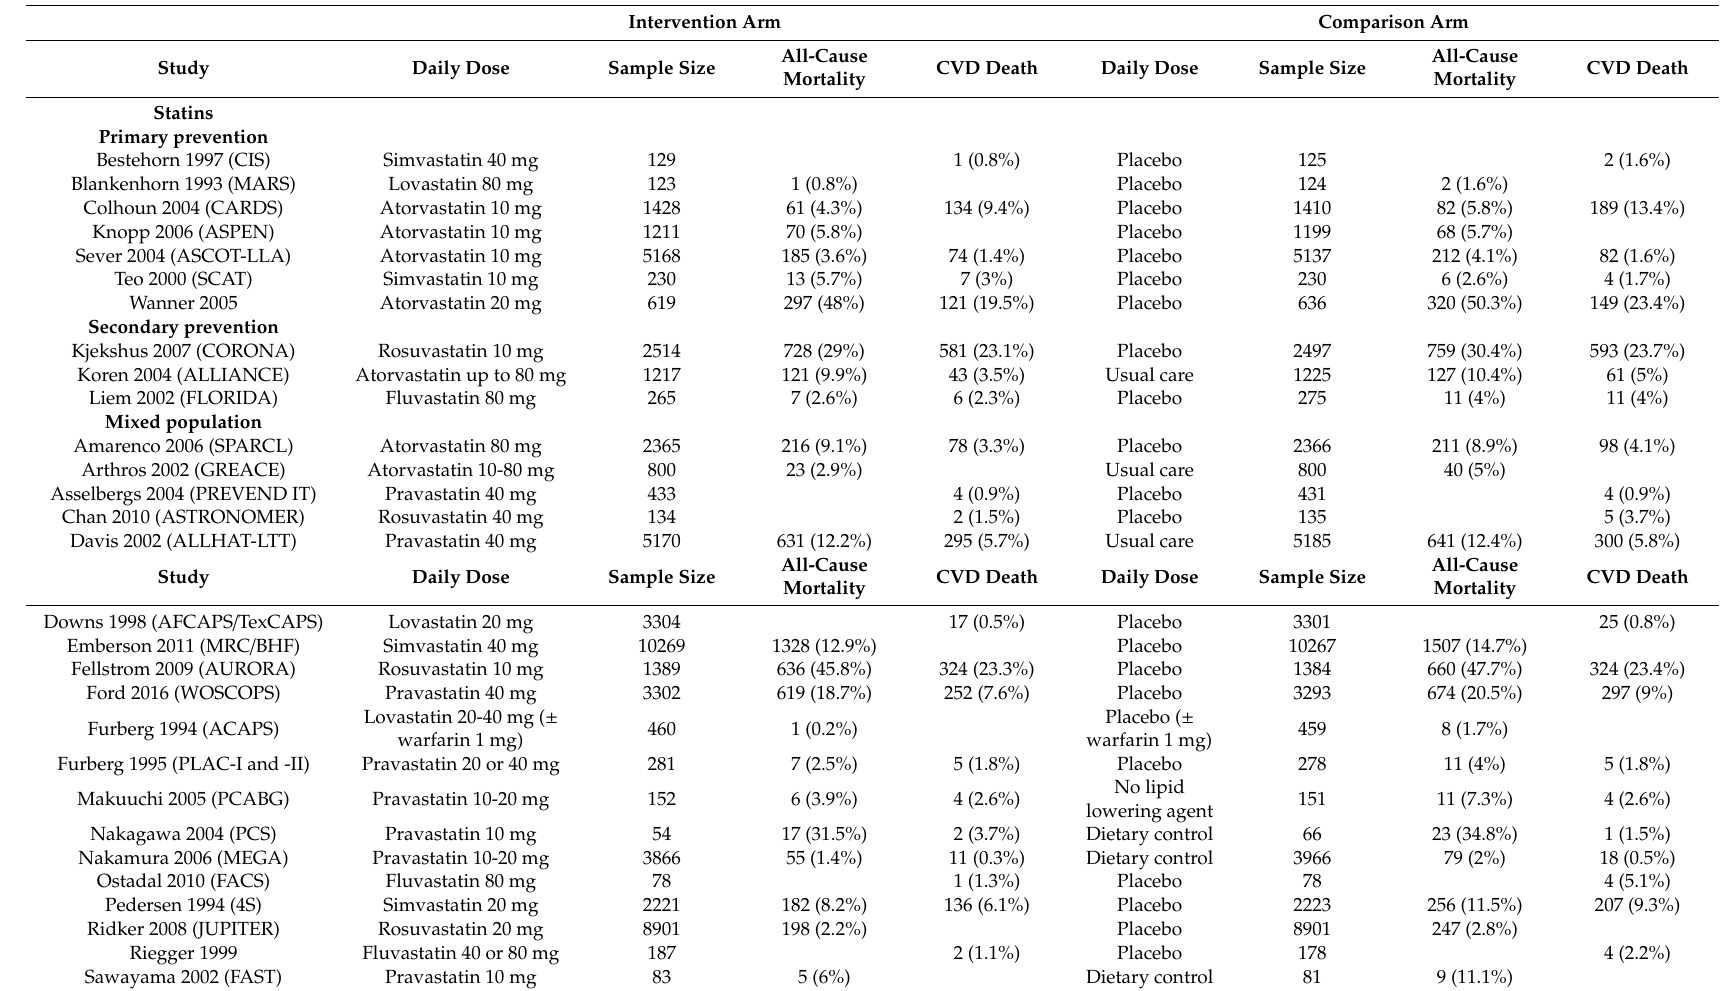
Table A3. Treatment arms and outcome events of studies included in the final